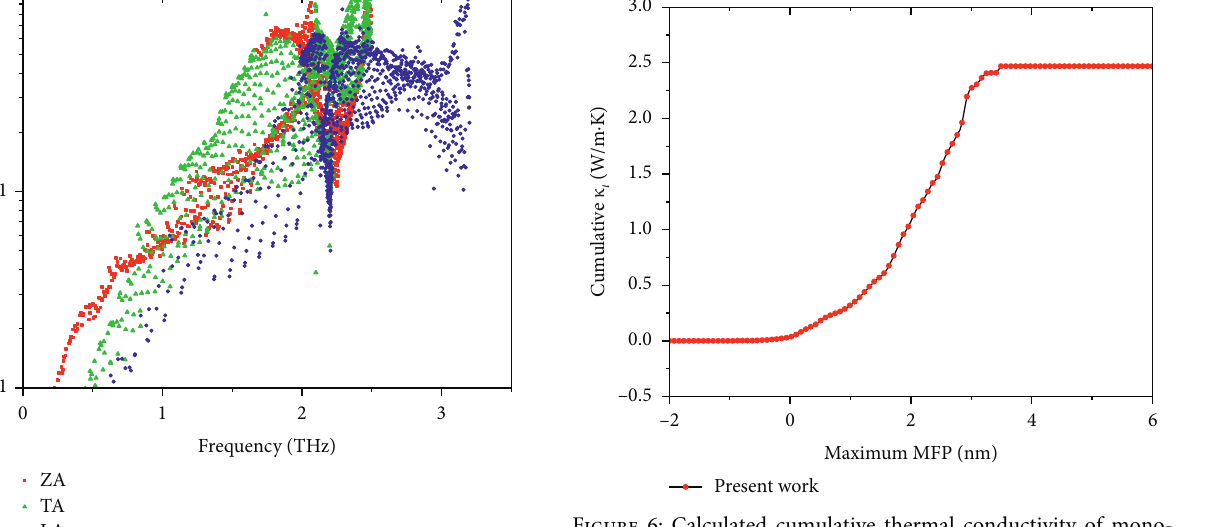
Figure 6: Calculated cumulative thermal conductivity of mono- layer CaHBr as a function of maximum mean free path (MFP) at room temperature.